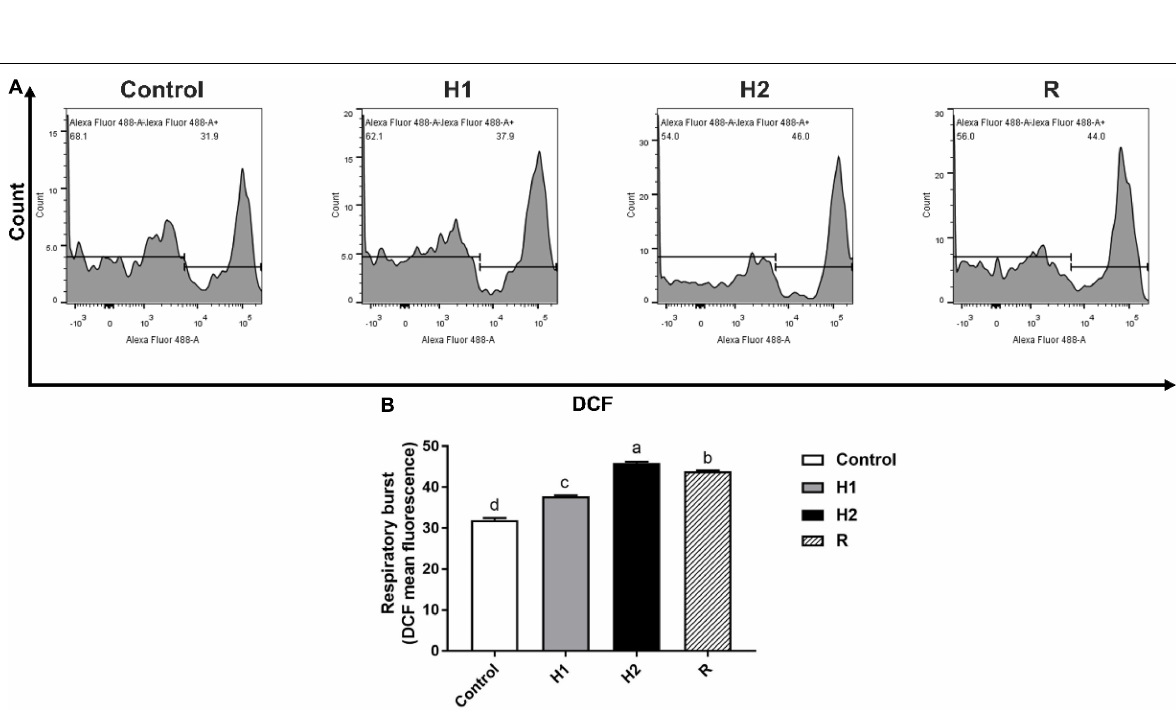
Frontiers in Ecology and Evolution |